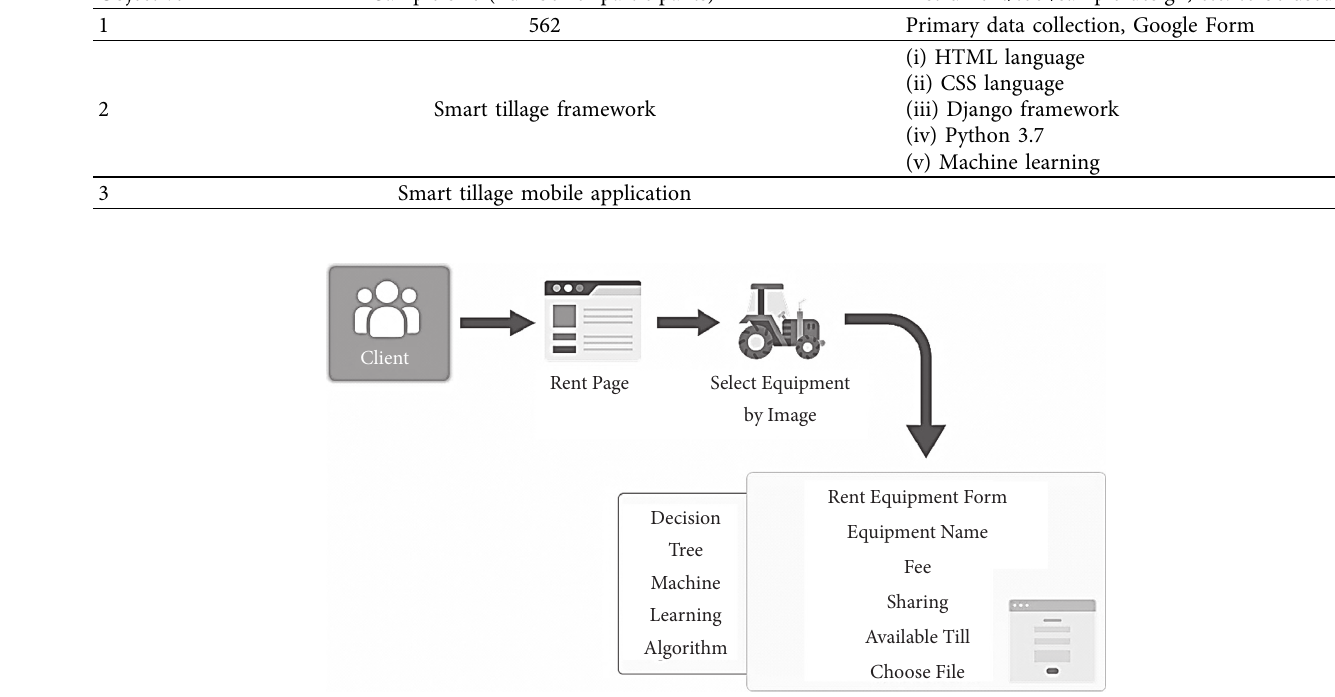
Figure 9: Systematic approach for renting equipment.